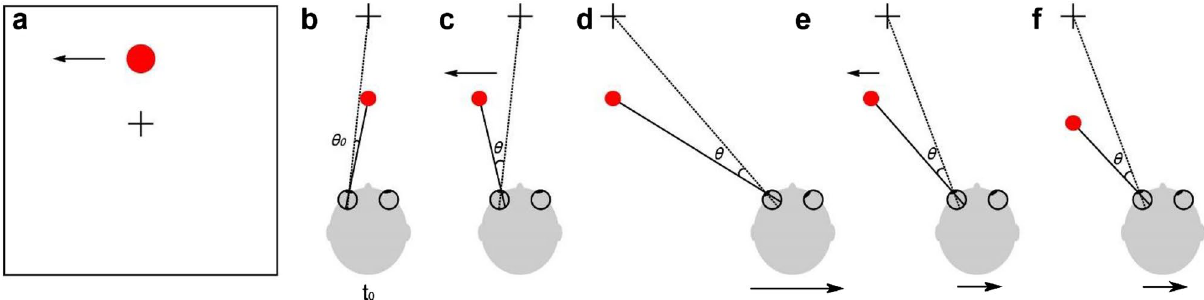
Figure 10. Multiple physical scenarios that could give rise to the same retinal image motion. ( a ) Frontal view of the image motion (in screen coordinates) associated with an object (red circle). ( b – f ) Schematic bird’s-eye view of a subject viewing the object in depth. ( b ) The subject’s eyes are fixated on a world-fixed point (black cross). The starting positions of the fixation point and the object are at the midline (time t 0 ). ( c – f ): Physical situations that could all give rise to the same net image displacement of the object, θ , at the end of the movement. ( c ) The object moves leftward in the world while the observer is stationary. ( d ) The observer moves rightward while the object is stationary in the world. ( e ) Both object and observer move in the world. Many possible combinations of object and observer motion could produce the same image motion. ( f ) The observer moves to the right more slowly than in ( d ), but the stationary object is located nearer to the